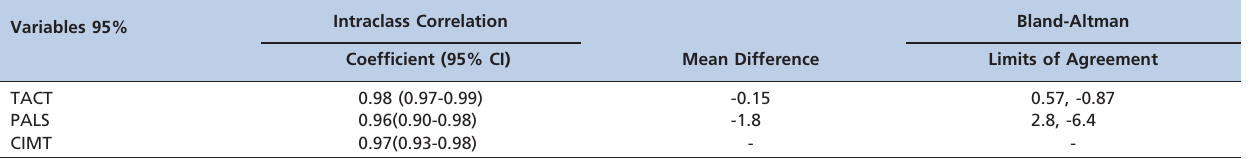
Table 6 - The Results of Inter- and Intraobserver Agreement